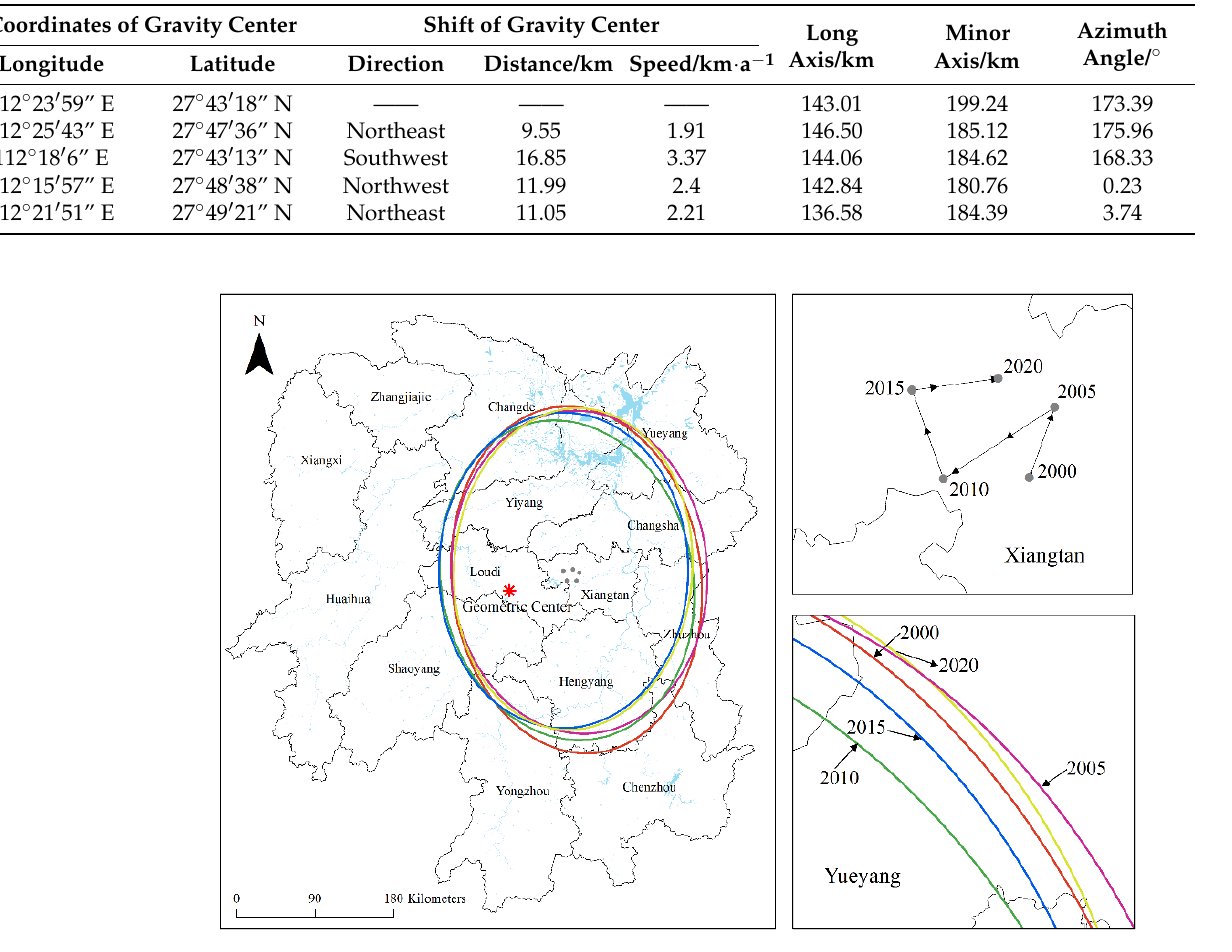
Figure 3. Ellipse distribution of carbon emission standard deviation and the movement trajectory of the center of gravity in Hunan Province.